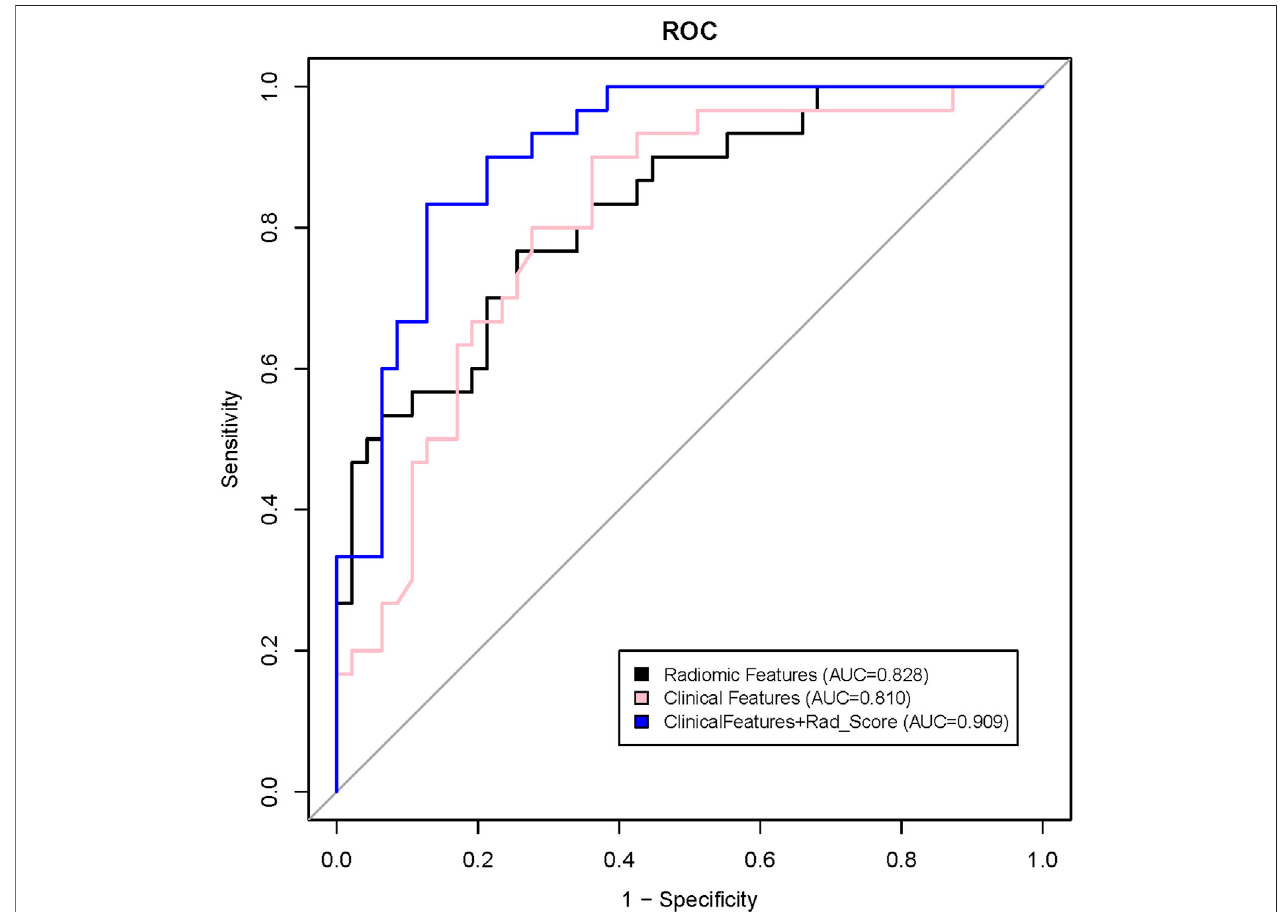
FIGURE 3 | Receiver operating characteristic (ROC) curves for prediction of brain metastases using a clinical model (pink line), a radiomic model (black line), and a model that combined Radiomics score (Rad_score) and clinical features (blue line).